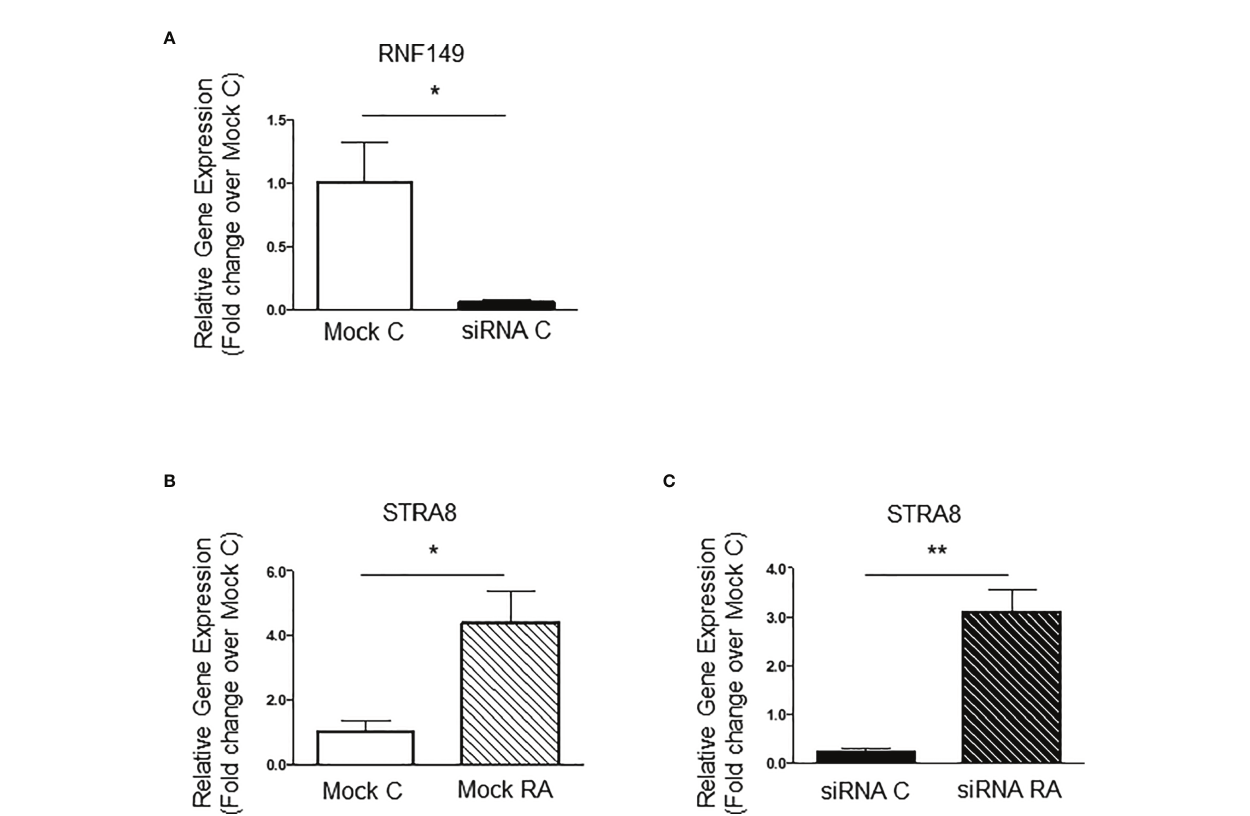
FIGURE 4 | RNF149 knockdown in F9 cells. (A) RNF149 mRNA expression in F9 cells treated with mock and siRNA for 48 hours. Results shown are from N=3 independent cell passages and are plotted mean ± SEM. *p-value<0.05. (B) Stra8 mRNA expression in F9 cells in mock cells treated with or without RA (10 -7 M) for an additional 24 hours. *p-value<0.05. (C) Stra8 mRNA expression in siRNA treated cells also treated with or without RA (10 -7 M) for an additional 24 hours.